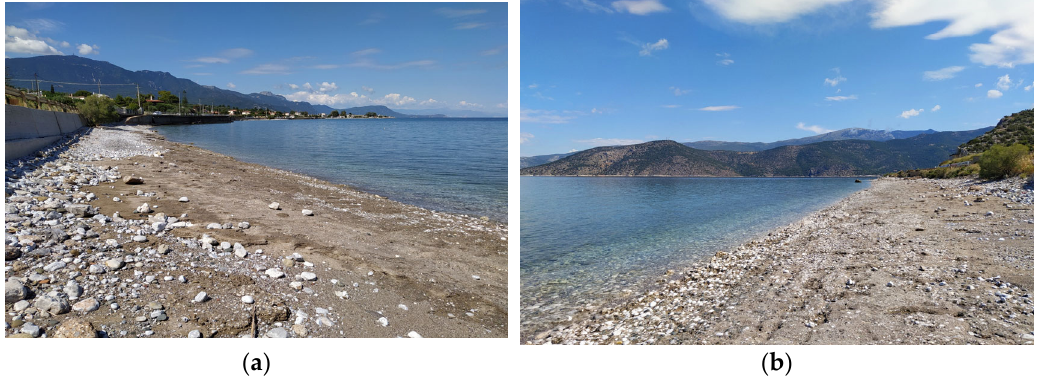
Figure 4. South ( a ) and north ( b ) view of the beachrock outcrop of Psatha.